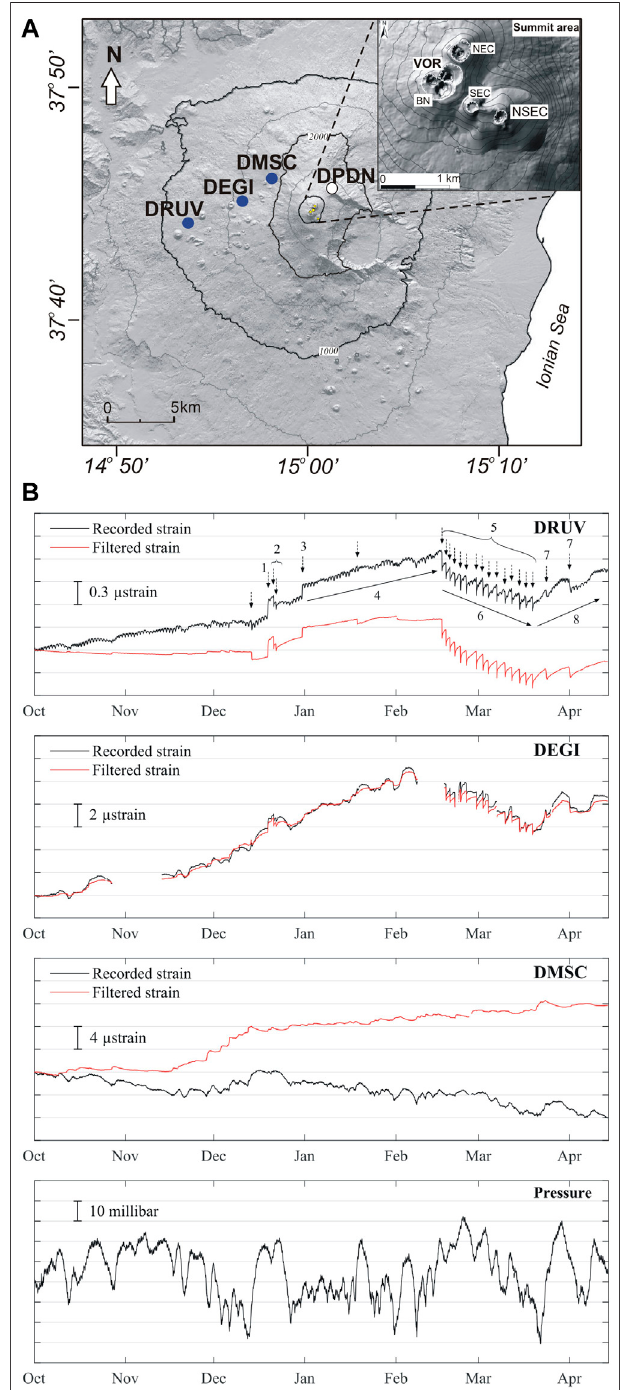
FIGURE 1 | (A) Etna borehole dilatometer network. The DPDN station was out of order in the period of this study. ( B ). Recorded and fi ltered strain datafromOctober1,2020toApril10,2021.1)strainchangerecordedduring the December 19, 2020 seismic swarm below the volcano pile with seismic earthquakes located at shallow depth; 2) two close lava fountains following the seismic swarm of 19 December; 3) pre-swarm strain change recorded on 31 December; 4) recharging compression phase; 5) strain ( Continued )